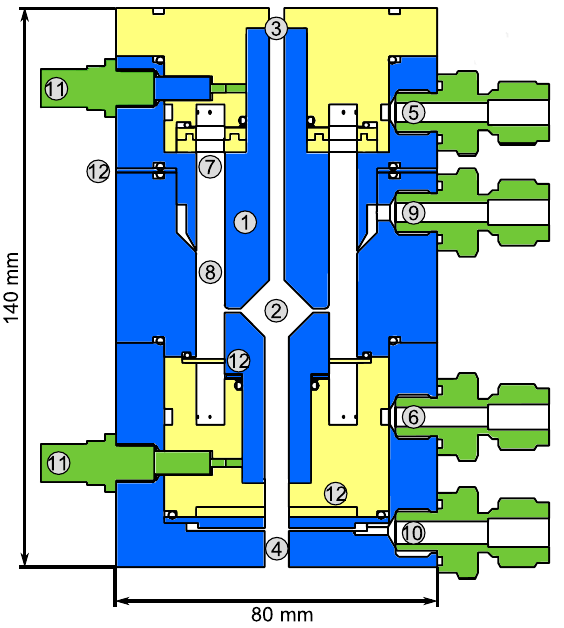
Figure 2. Schematic quarter section of the DMA unit of the TD- DMA with (1) central electrode, (2) collection area, (3) inlet for the filament, (4) outlet for the filament, (5) sheath flow inlet, (6) sheath flow outlet, (7) tissue for laminarizing the sheath low, (8) selec- tion area, (9) aerosol inlet, (10) aerosol outlet, (11) SHV supplies and (12) spacer plates. Conductive stainless steel parts are shown in blue, isolating PEEK parts in